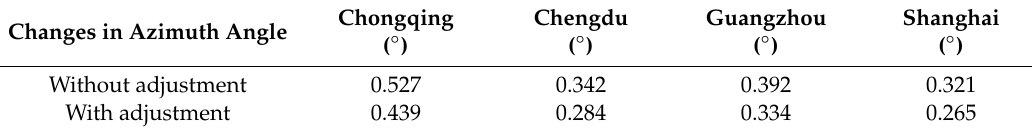
Table 2. The average Hausdorff distance statistics of different methods. Table 4. The average changes in the turning angle in the spatial directional